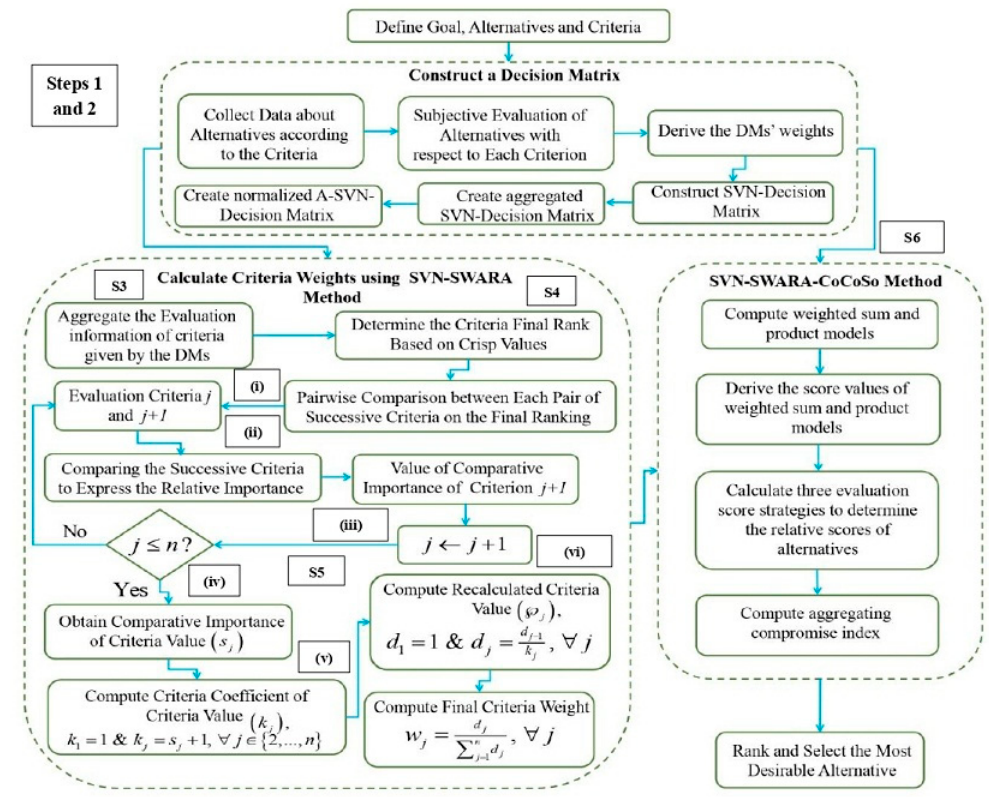
Figure 1. Flowchart of the SVN-SWARA-CoCoSo method (S3 to S6 means Step 3 to Step 6).